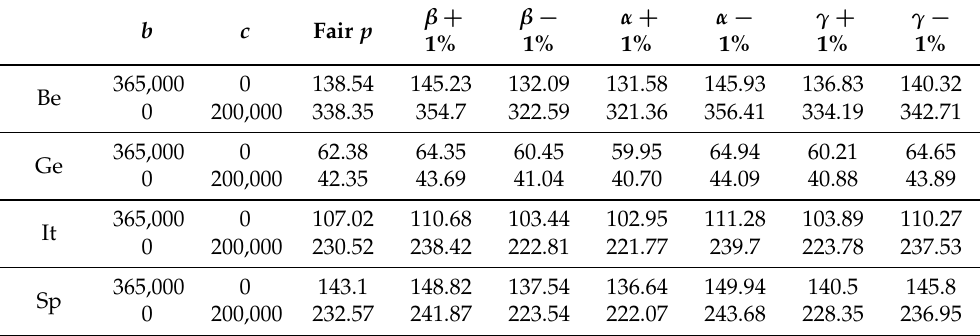
Figure 2. Comparison of fitted I t with observed ones and those computed with the SIR model. Table 4. Fair premium rates with the model in (1). Duration T = 0.5 year and r = 2%.